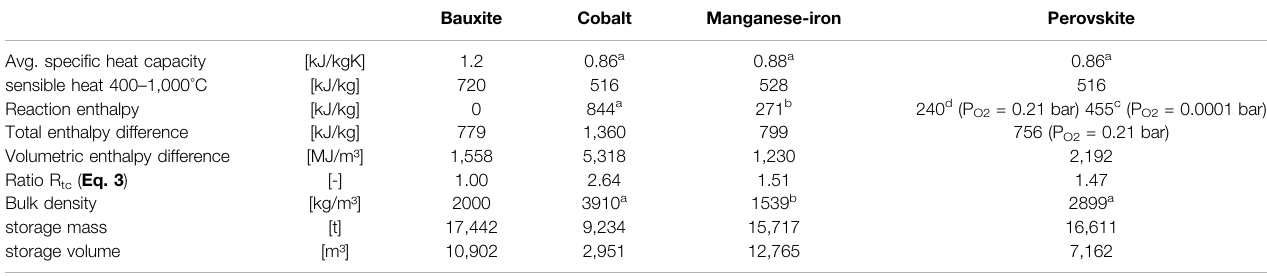
TABLE 1 | Comparison ofthermophysical properties of considered materials (values from: a [Jackson et al., 2019], b [Wokon et al., 2017b], c [Imponenti et al., 2017], d [Yilmaz et al., 2021], e [Preisner et al., 2018]). Bauxite